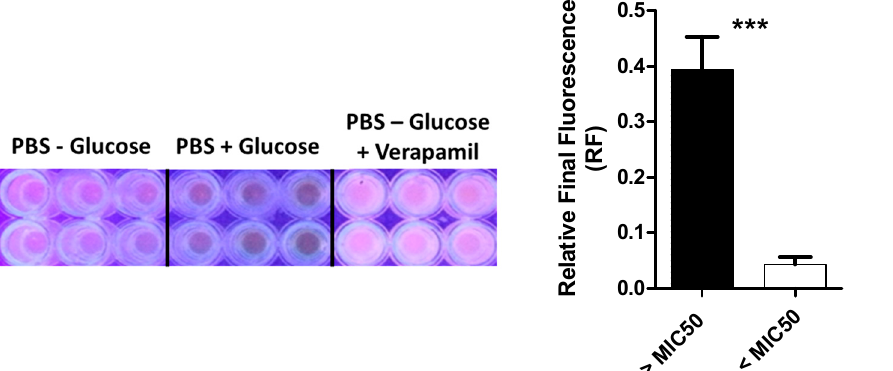
Figure 9. Increased efflux in highly resistant isolates. A quantitative fluorometric assay of EtBr efflux was performed for 20 high-resistant isolates (MIC > MIC 50 to MLS antibiotics and biocides) against 20 resistant isolates (MIC < MIC 50 to MLS antibiotics and biocides). The efflux assay was performed at conditions that cause maximum accumulation of EtBr in the presence of efflux pump inhibitor verapamil and limited energy supply (absence of glucose and low temperature). The efflux of EtBr is presented in terms of relative fluorescence (RF), which is obtained from the comparison between the fluorescence observed for the bacteria in the presence or absence of glucose and the control in which the cells are exposed to conditions of minimum efflux in the absence of glucose and presence of verapamil. All fluorescence readings were made at excitation and emission wavelengths for EtBr (530 nm and 585 nm, respectively). All data were acquired in cycles of 60 s, during 1 h time intervals, and at 25 ◦ C. Each experiment was conducted in triplicate, and the results obtained were averaged. The relative fluorescence was calculated for each isolate with MICs to biocides >MIC 50 or <MIC 50 , and results were expressed as means ± standard deviation. *** p -value < 0.001 was considered significant using Student’s t -test. Significantly, the efflux of EtBr was increased in the isolates with MIC > MIC 50 , indicating high efflux activity that could explain high resistance to both biocides and